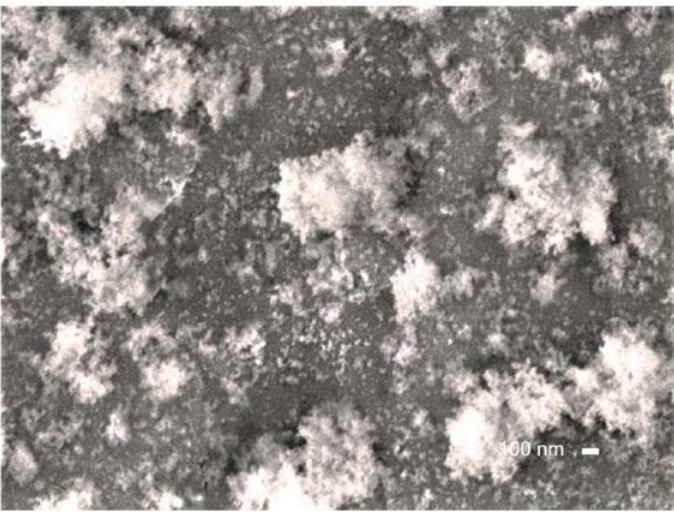
Figure 11. High resolution SEM image of the film on Ti substrate from Figure 9c in DC plasma jet.